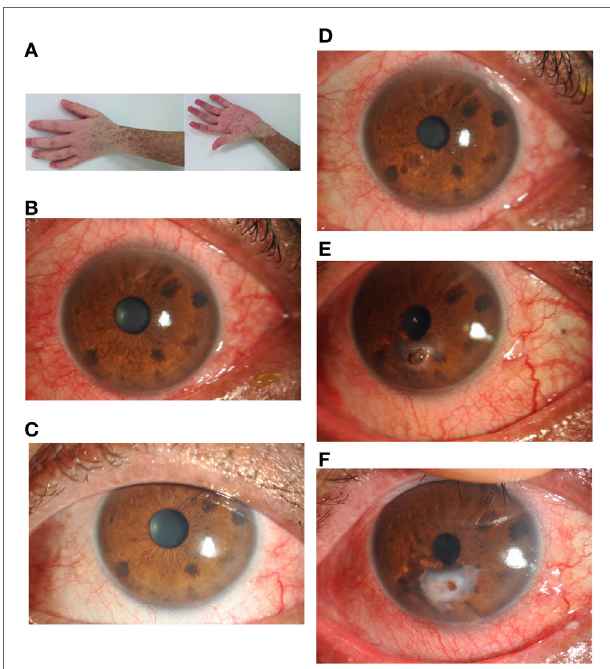
P, the results of each stage after treatment and before treatment were compared,